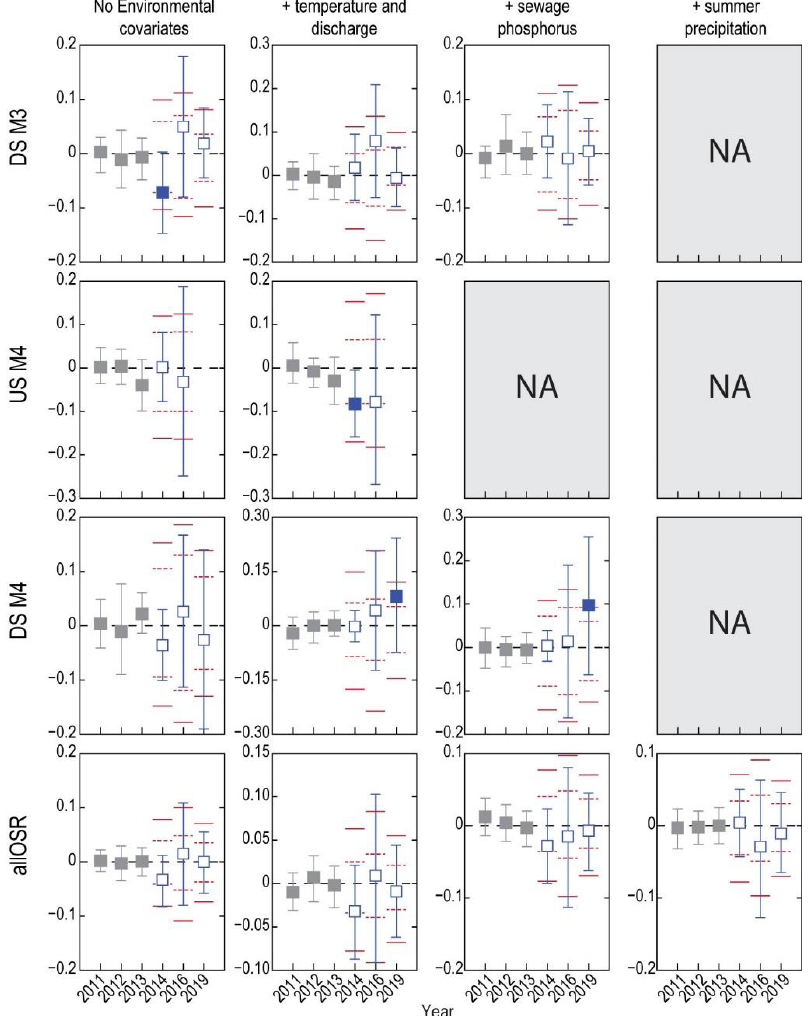
Figure 3. Median residual liver weight (LW) of female white sucker (±log10; g) from site-specific regressions done without environmental covariates, with T and D, with T, D, and P, and either T, D, P, and Pr, or T, D, and Pr; “NA” indicates a non-applicable analysis; upper and lower dashed horizontal red lines denote 97.5 and 2.5 percentiles, respectively; upper and lower solid horizontal dashed lines denote outer tolerance limits for the 97.5 and 2.5 percentiles, respectively; error bars in observed test and reference data show 95% confidence intervals; solid symbols suggest a potentially relevant difference; open symbols show potentially irrelevant differences; solid grey symbols denote baseline years (2011–2013) used to derive thresholds used for test years (2014, 2016, 2019).